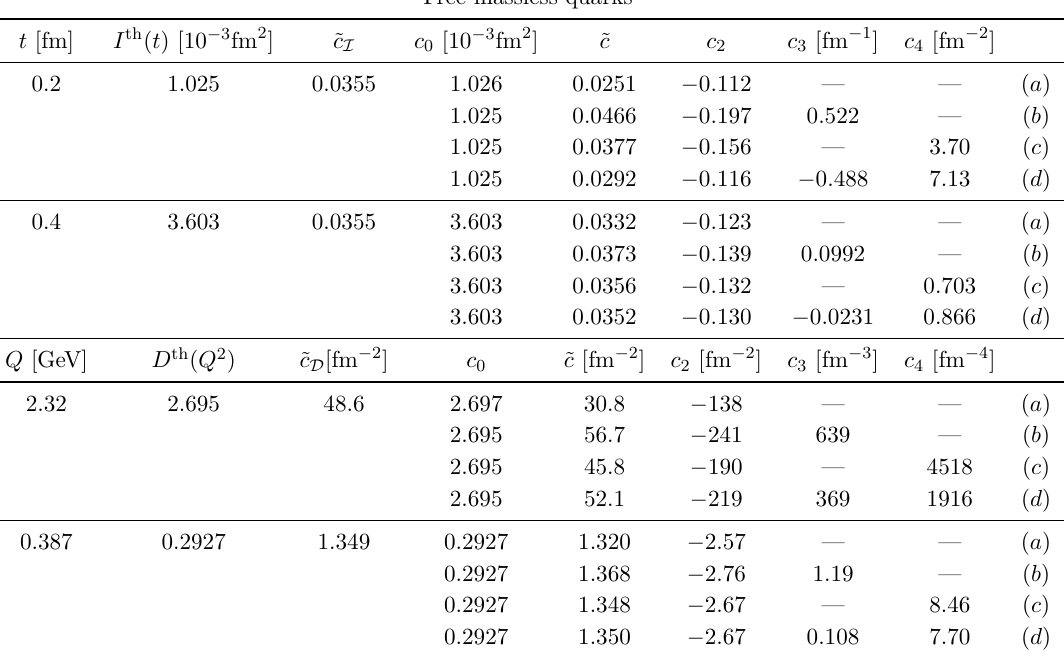
Table 1 . Parameters of the continuum extrapolation of I th ( t ) and D th ( Q 2 ) with the functional forms ( a ) , ( b ) , ( c ) , ( d ) of eq. (3.12). The known continuum values I th ( t ) and D th ( Q 2 ) are